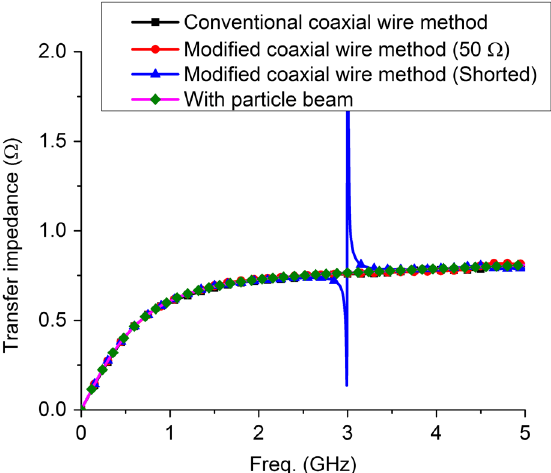
FIG. 9. Transfer impedance of the test BPM obtained through simulation of the BPM.